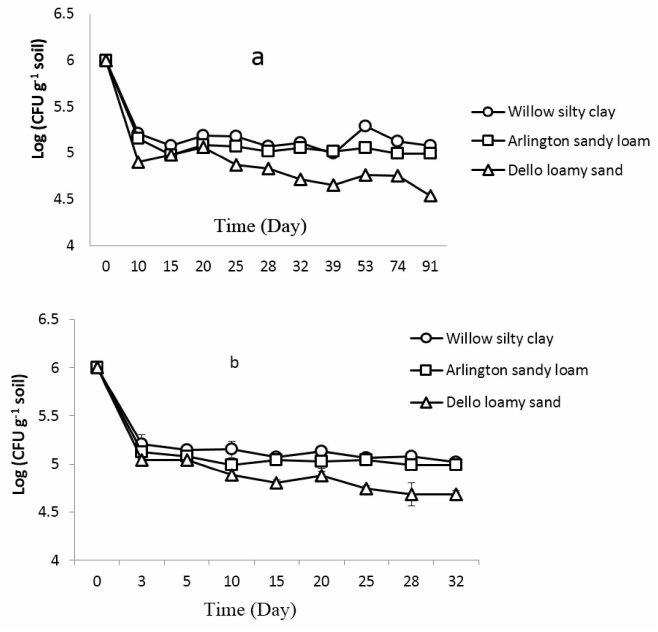
Figure 1. Abundance of B. subtilis B068150 in ( a ) rhizosphere; ( b ) non-rhizosphere clay, loam, and sandy